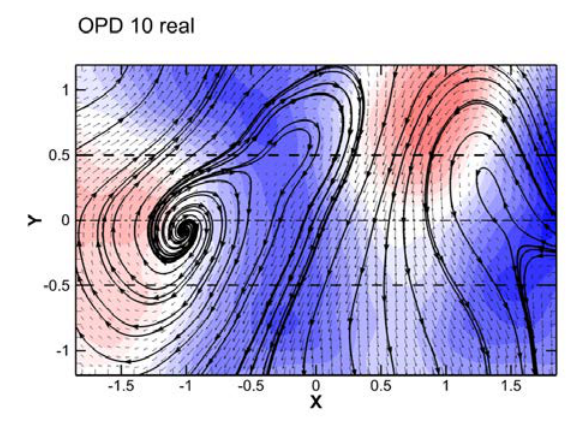
Fig. 11. Real part of the OPD mode 15 topology .